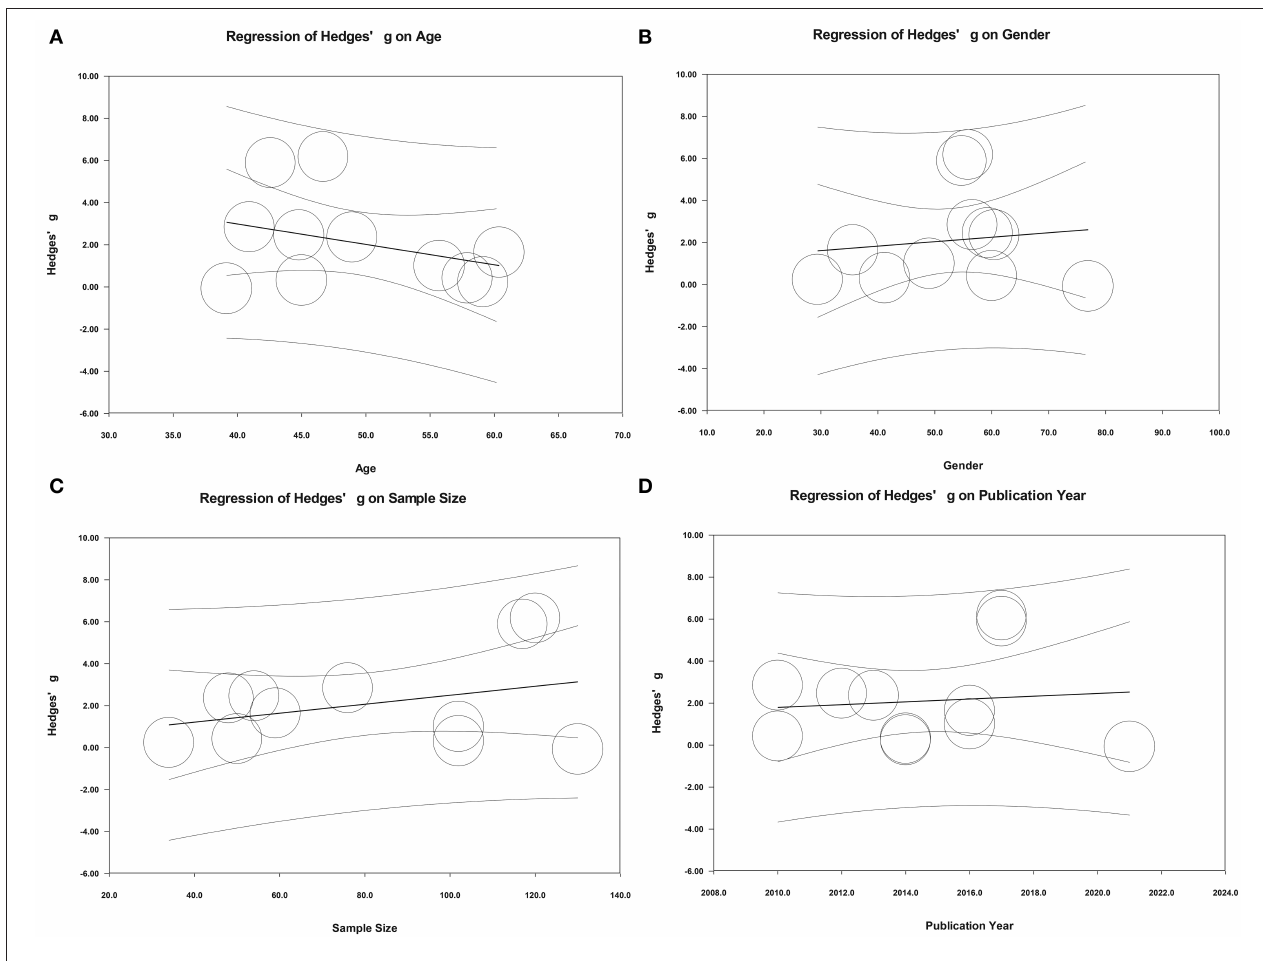
FIGURE 7 | (A–D) Meta-regression in all